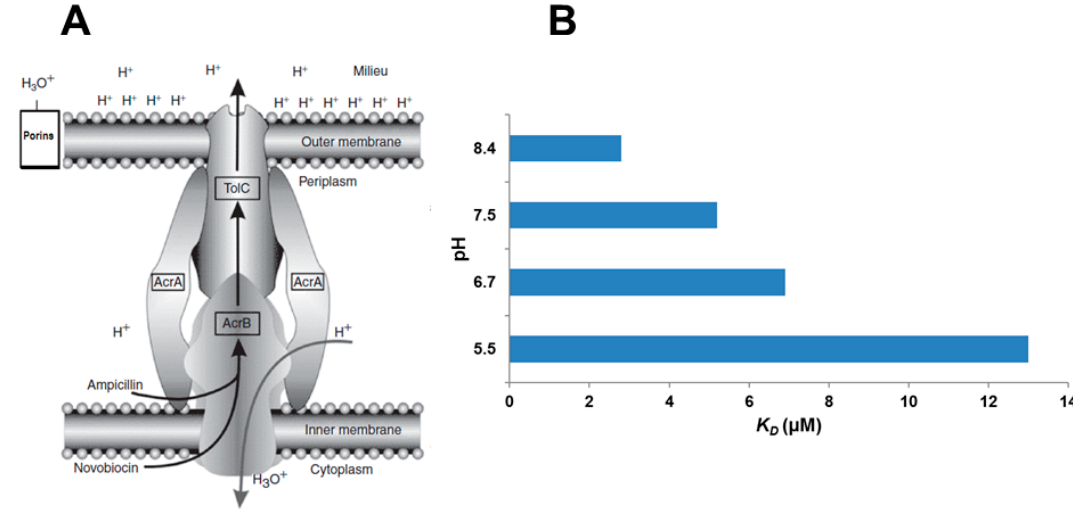
Figure 1. Simplified structure of the AcrAB-TolC pump of a Gram-negative bacterium and proposed mechanism of action (( A ): adapted from [101], ( B ): adapted from [160]). ( A ) The AcrAB–TolC efflux pump consists of two fusion proteins AcrA (made of six monomers) that anchors the AcrB transporter (made up of three monomers) to the plasma membrane. The latter is connected to the TolC channel (which consist of three monomers, therefore the stoichiometry of the respective pump proteins AcrA–AcrB–TolC is 3:6:3. providing a conduit to the exterior of the bacterium [161]. Noxious agents